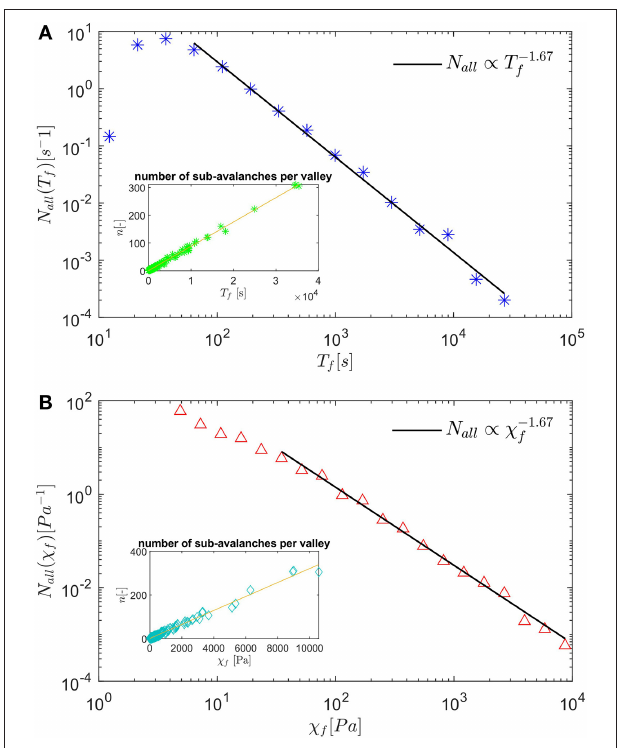
FIGURE 10 | (A) Distribution of forward time-directed avalanches. The black T − 1.67 f . In the inset we present a scatter plot line denotes the scaling N all ( T f ) ∝ illustrating the correlation between the avalanche size T f (in seconds) and the number n of sub-avalanches within it. The measured Pearson coefficient was 0.998. (B) Distribution of forward valley sizes. The black line denotes the χ − 1.67 scaling N all ( χ f ) ∝